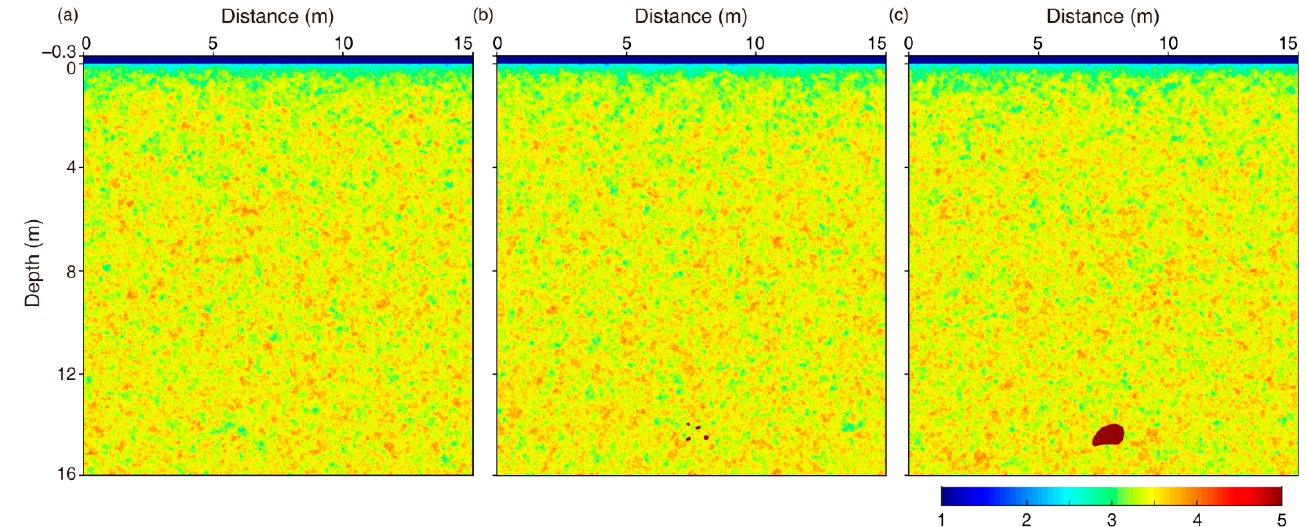
Remote Sens. 2021 , 13 , x FOR PEER REVIEW Figure 7. The random model: ( a ) without rocky blocks; ( b ) with ~20 cm rocks; ( c ) with a ~1 m rock.